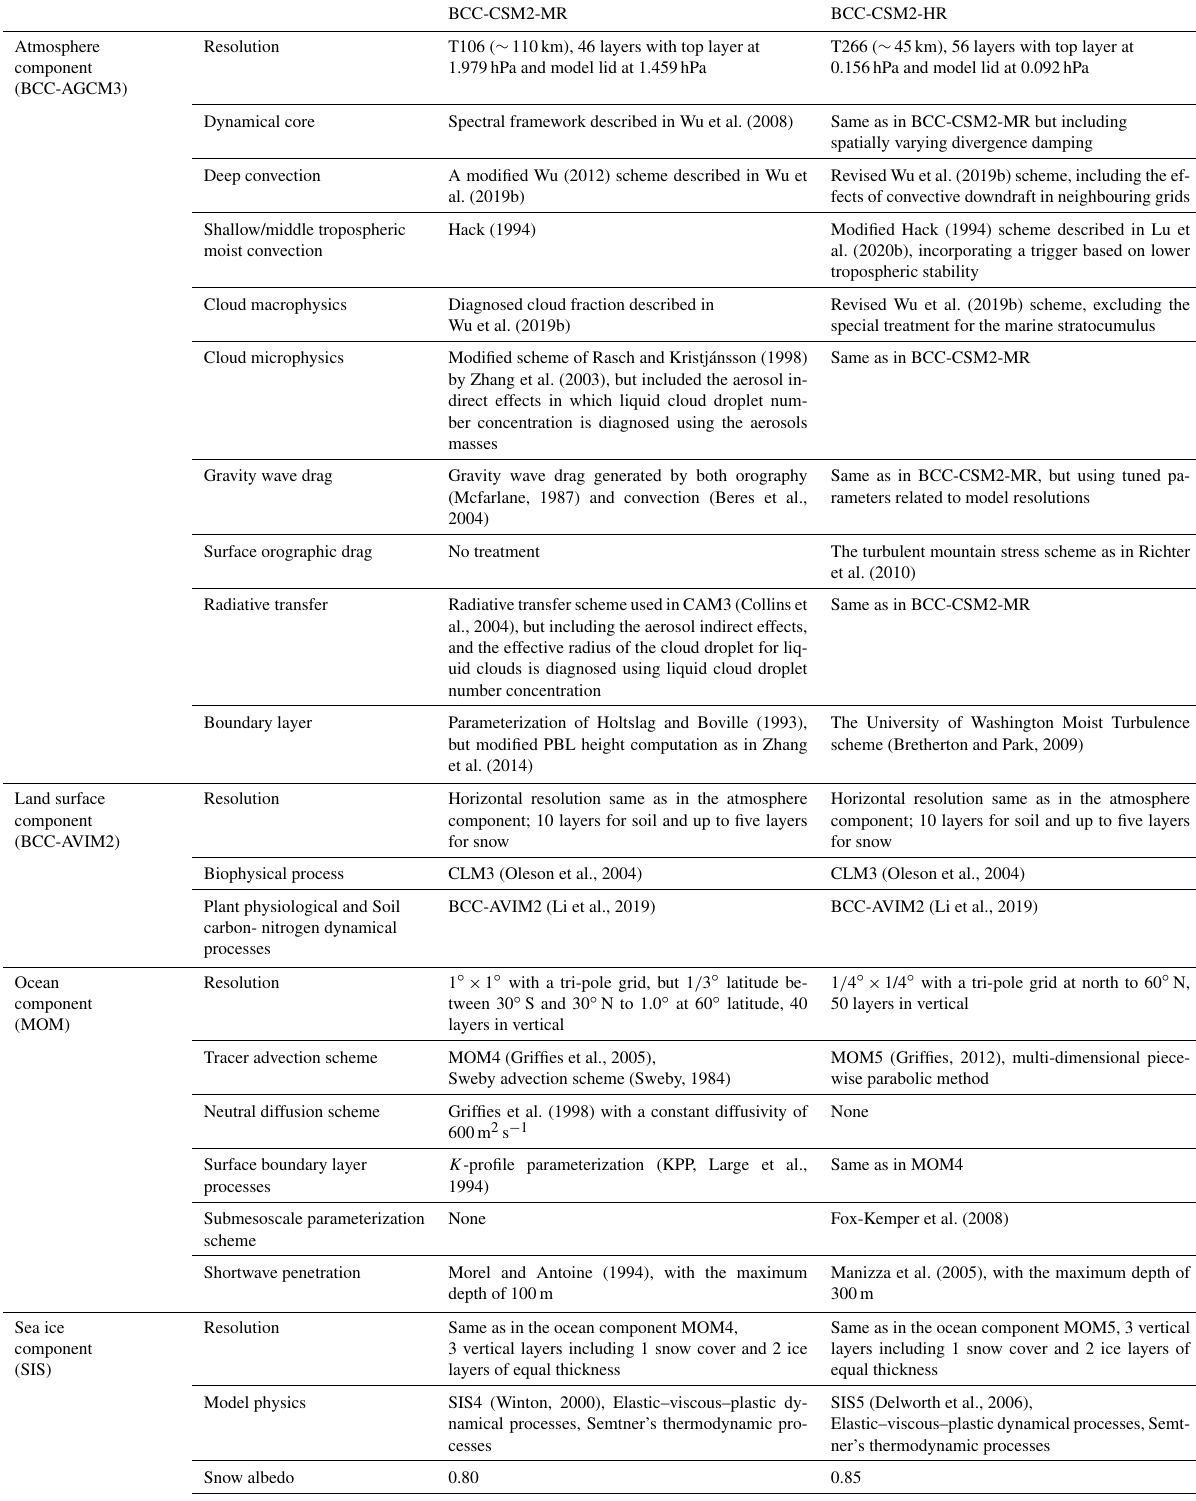
Table 1. Constituents and configurations of BCC-CSM2-MR and